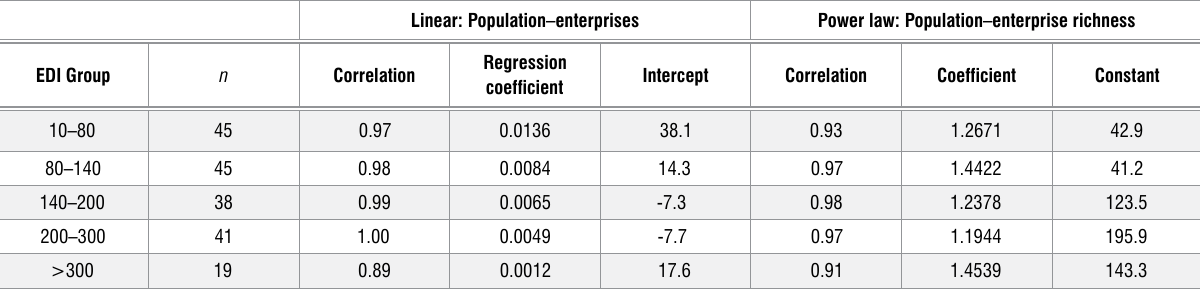
The linear population:enterprises relationship and the power law population:enterprise types relationship of groups of towns with different Enterprise Dependency Indices (EDIs) linear: population–enterprises power law: population–enterprise